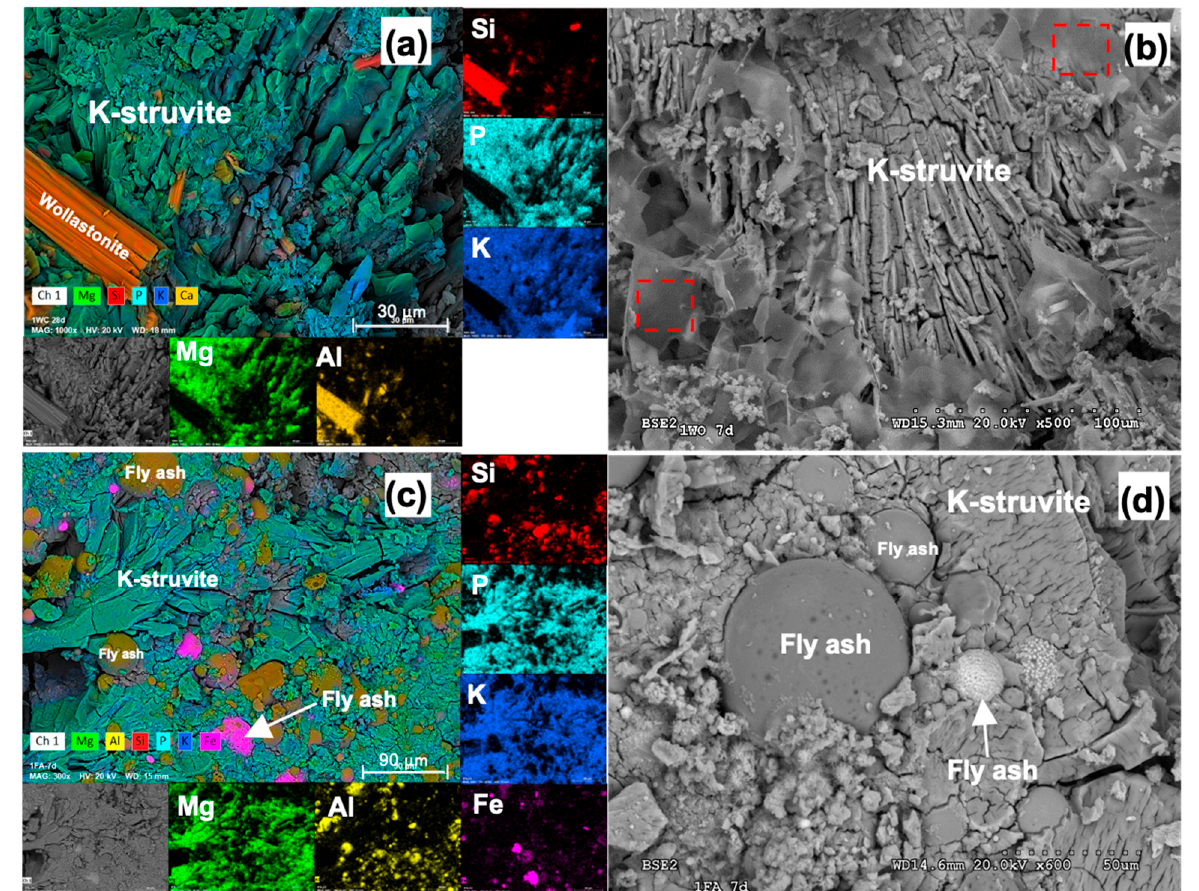
Figure 7. SEM images of MKPC pastes with WO ( a , b ) and FA ( c , d ) fillers in fresh fractures.